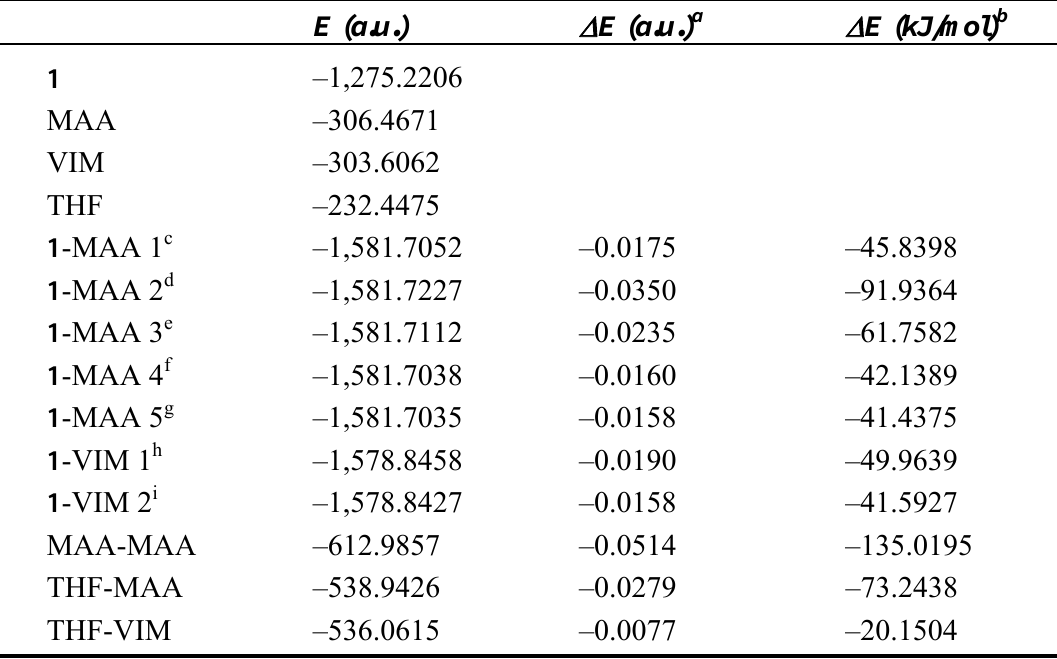
Table 2. Interaction energies of 1 with MAA or